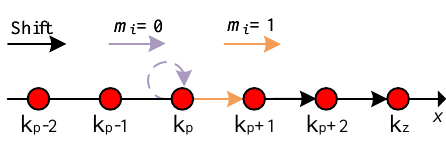
Figure 1. Illustration of 1D HS-based method.